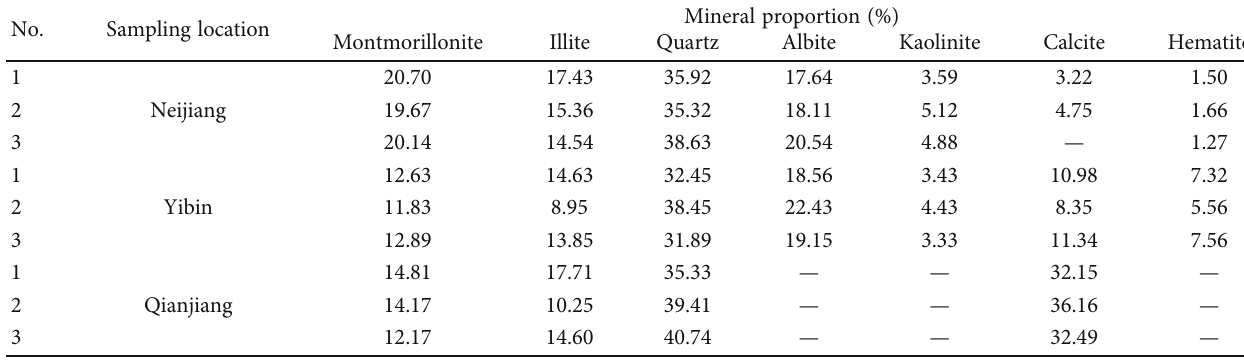
Table 2: Mineral composition and quantitative proportion.